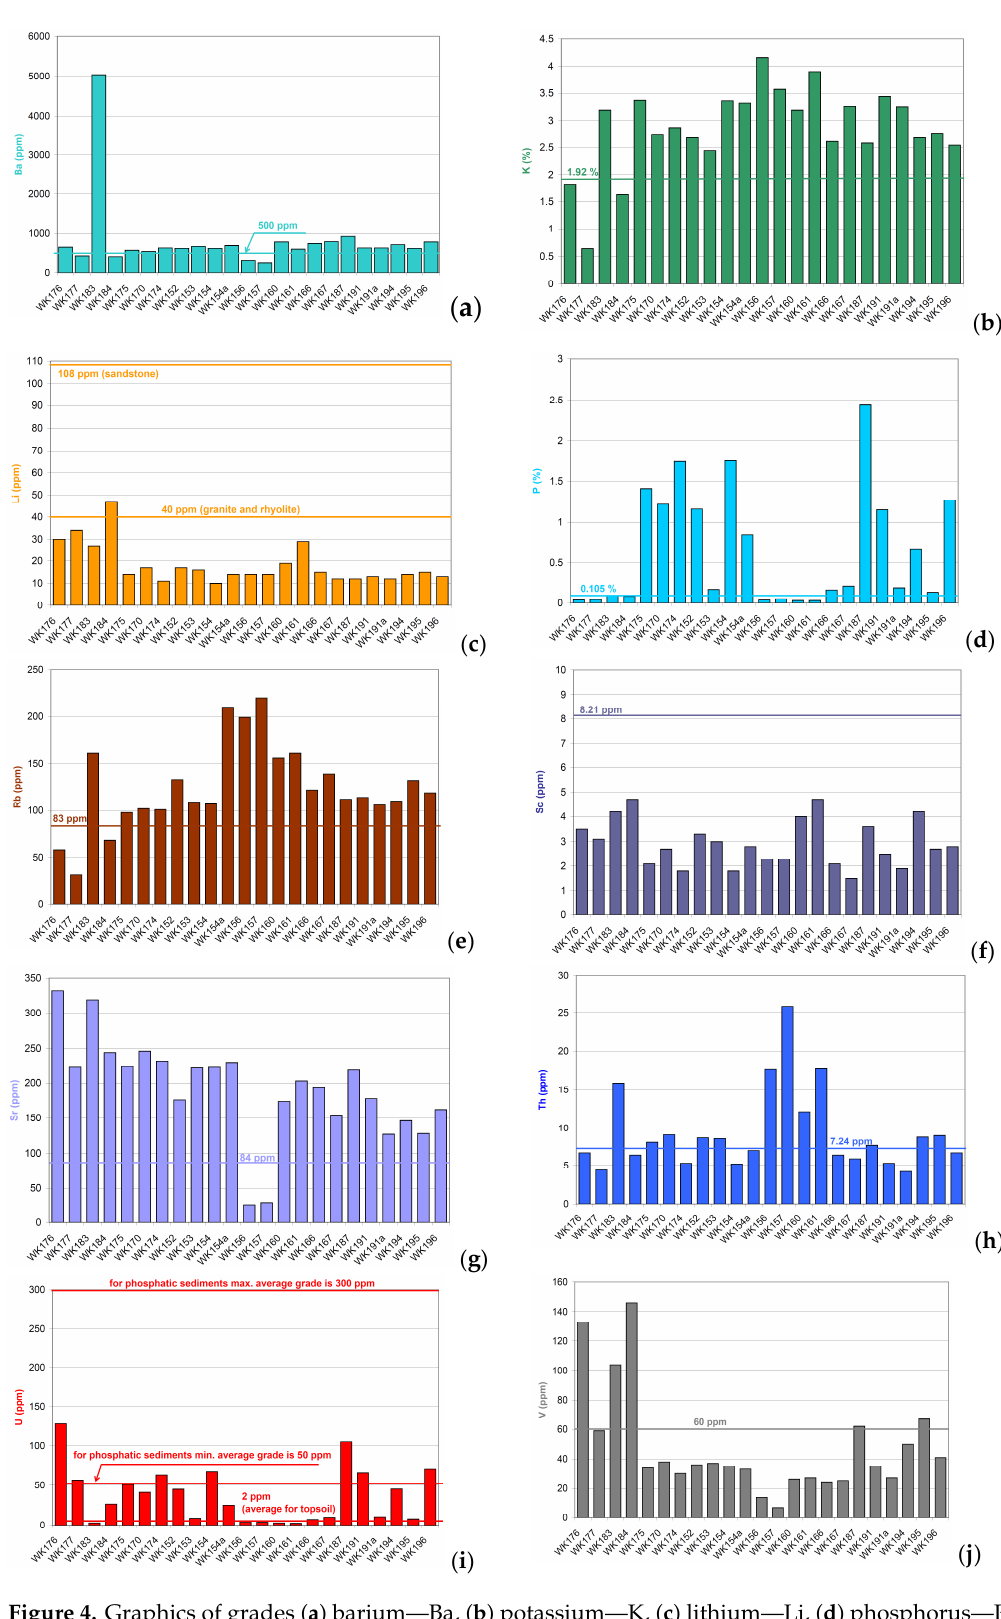
Figure 4. Graphics of grades ( a ) barium—Ba, ( b ) potassium—K, ( c ) lithium—Li, ( d ) phosphorus—P, ( e ) rubidium—Rb, ( f ) scandium—Sc, ( g ) strontium—Sr, ( h ) thorium—Th, ( i ) uranium—U, ( j ) vanadium—V.